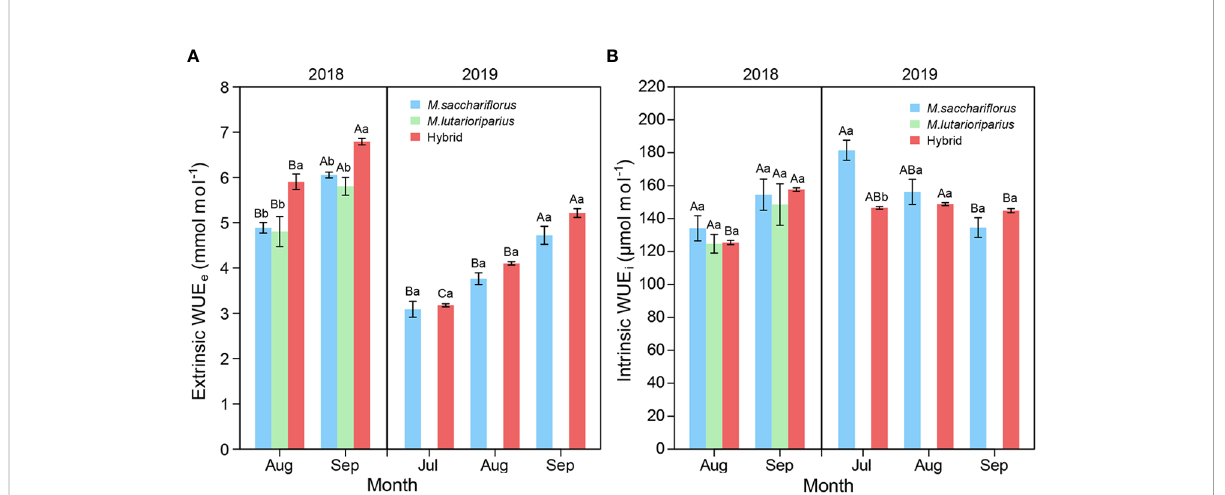
FIGURE 4 Differences of (A) average WUE e , (B) WUE i between measuring hybrid and female parent individuals during the 2018 and 2019 growing season, and male parent individuals in 2018. Different capital letters A, B, and C represent a signi fi cant difference of WUE e and WUE i between growth months at P <0.05 level, respectively. Different lowercases a and b represent a signi fi cant difference between M. sacchari fl orus , M. lutarioriparius and their hybrids at P <0.05 level, respectively. Error bars indicate standard error of 333 surviving hybrid individuals, 5 and 3 surviving female parent individuals in both 2018 and 2019, and 10 surviving male parent individuals in 2018, respectively.